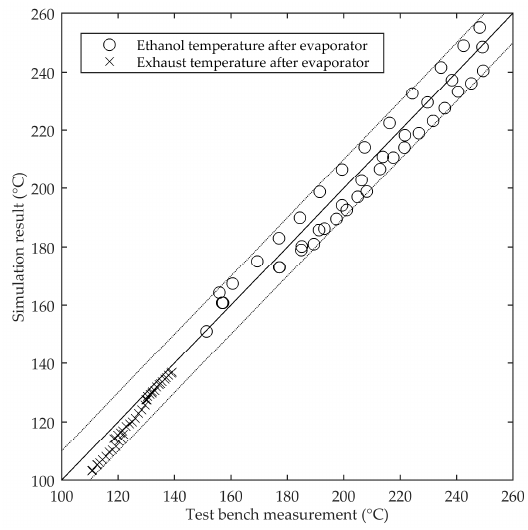
Figure 5. Ethanol and exhaust evaporator outlet temperature, comparison of test bench measurement and simulation results (dashed lines: ±10 K) [18].